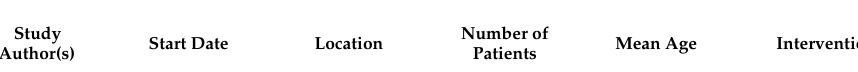
Table A2. Summary of the